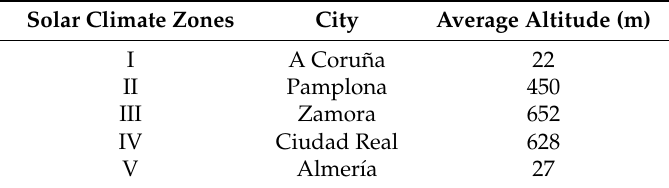
Table 11. Average altitude of the di ff erent study cases in the calculation of solar